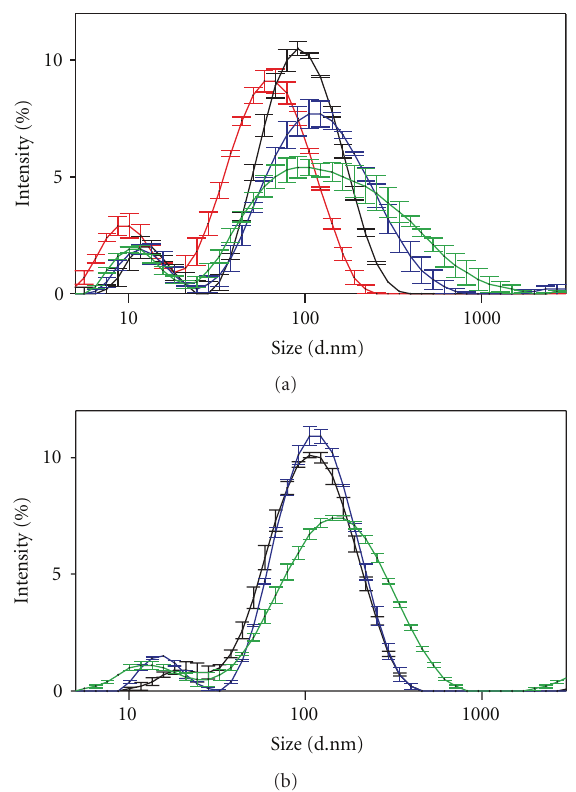
Figure 2: Dynamic Light Scattering (DLS) size distributions for (a) the nanosilver stock preparation (red line) along with the pH 6.9 200 mg L − 1 NaCl solvent condition 5 min (black line), 1 hour (blue line), and 24 hours (green line). (b) The nanosilver mixed with head tank water directly (1:1) (black line), after 30 min (blue line), and 24 hours (green line). Data are presented as mean value ±